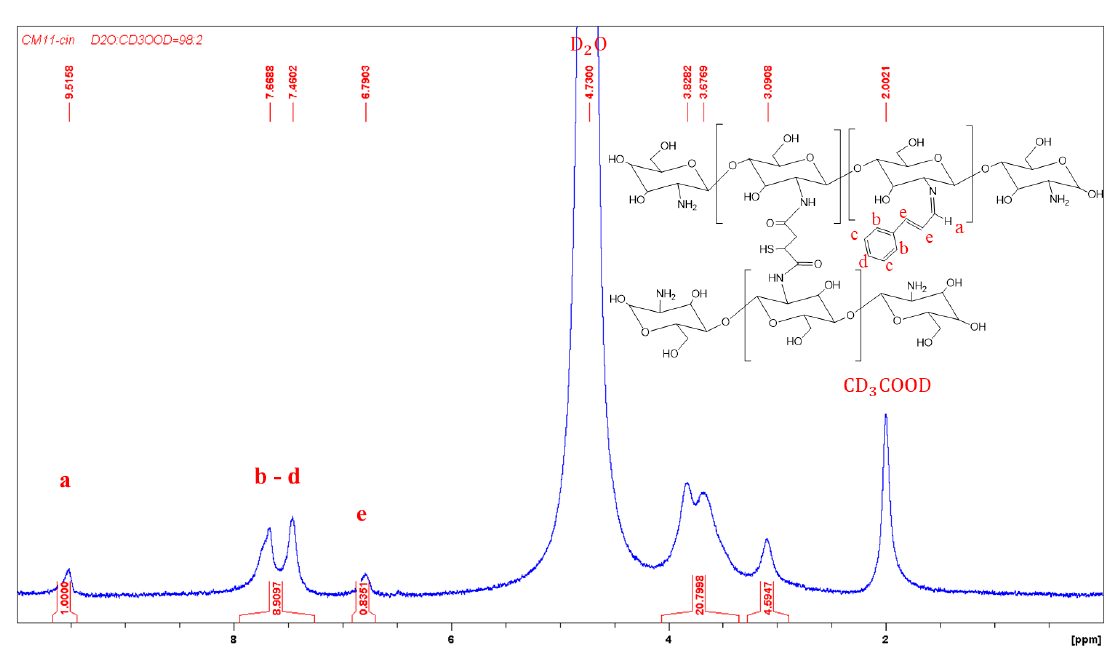
Figure 2. The 1 H-NMR spectra of various cinnamaldehyde-modified crosslinked chitosan, a, b, c, d, and e are the corresponding H atoms to the indicated peaks.